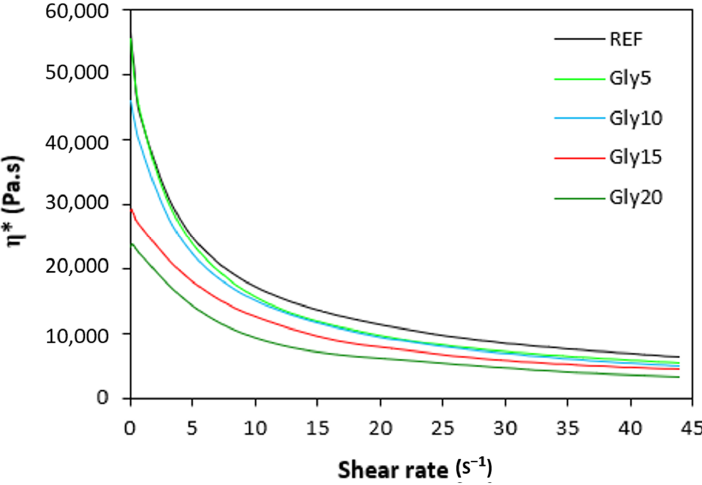
Figure 13. Dependence of dynamic complex viscosities η* of rubber compounds NBR/CB-L30 on shear rate.